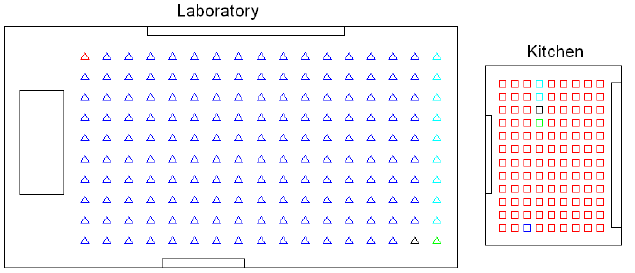
Figure 5. Results of the intermediate-level clustering in the kitchen and laboratory, using the hierarchical algorithm and gist. Bielefeld